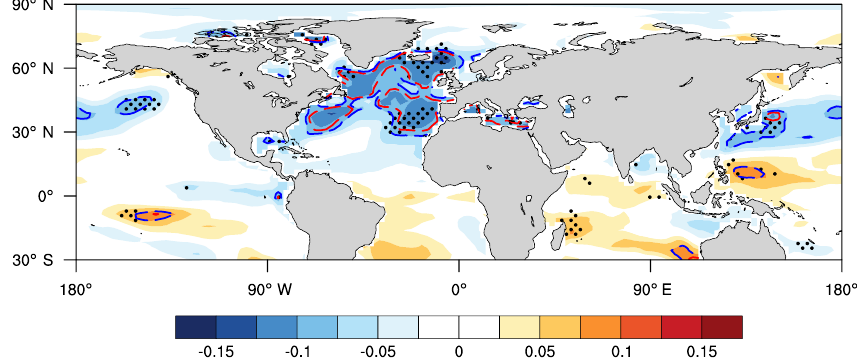
Figure 11. MEM of correlation coefficients between 31-year RCs and 31-year running averaged summer sea surface temperature (SST) anomalies among CESM-LME full-forcing experiments. The red (blue) dashed lines represent the 95% (90%) significance level estimated from 10000 Monte Carlo simulations. Dotted areas show that at least seven of nine ensemble members have the same sign with MEM